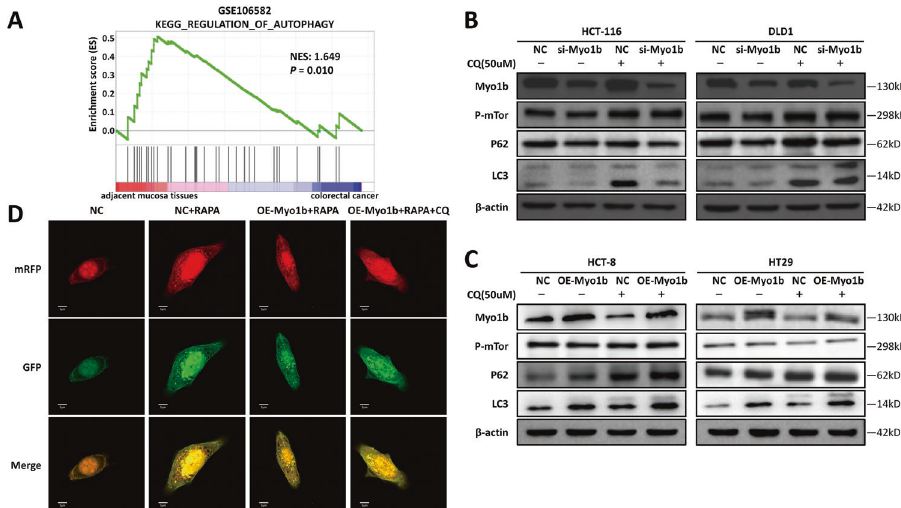
Fig. 3 Myo1b mediates autophagy process by blocking autophagosome-lysosome fusion. A GSEA based on GEO dataset (GSE106582) indicated autophagy-related pathway was enriched in adjacent mucosa tissues when compared with colorectal cancer. B, C Western blot analyses of Myo1b, p-mTOR, P62 and LC3 in the CRC cells silencing or overexpressing Myo1b were performed in the presence or absence of Chloroquine (50 μ M, 6 h). D Intensity of MAP1LC3 punctate in HCT-8 cells was analyzed after transfected with Myo1b over-expression vector or cultured with RAPA (500 nM, 24 h) and CQ (50 μ M, 6